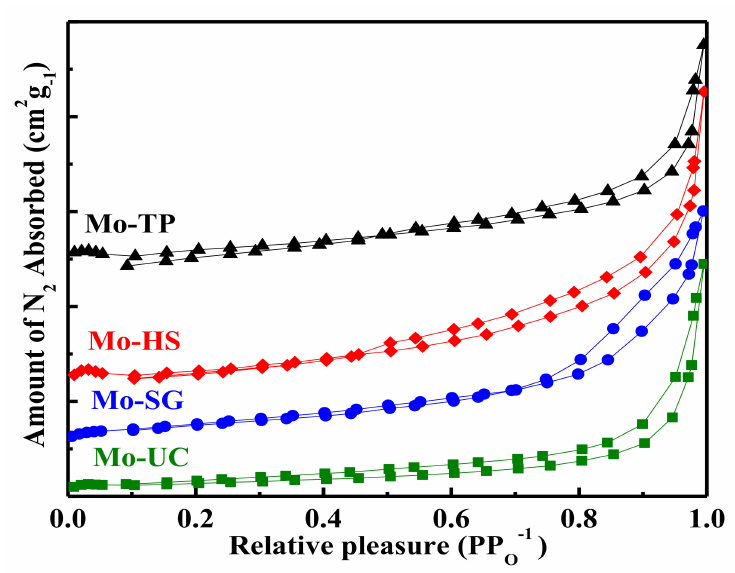
Figure 4. N 2 adsorption-desorption isotherm curves of the Mo/ZnAl-LDH catalysts.